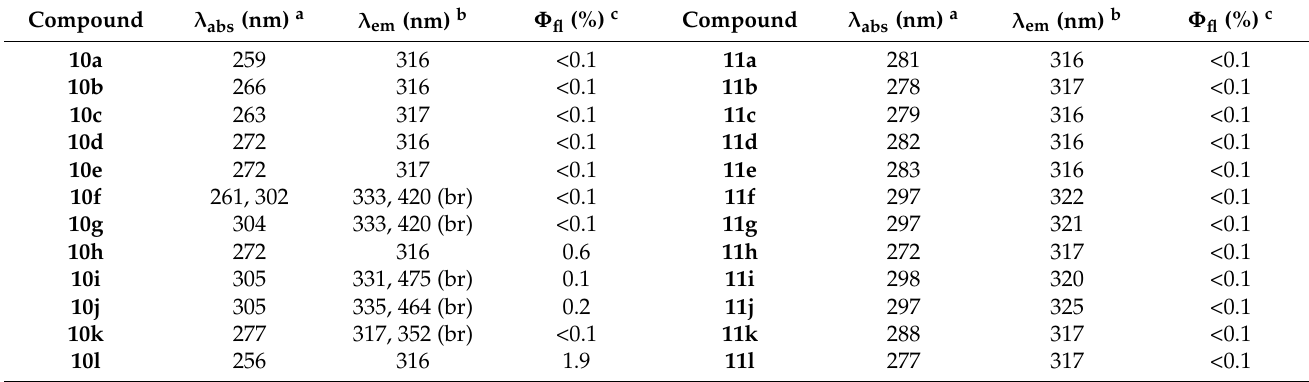
Table 2. The photophysical properties for the obtained molecules 10 and 11